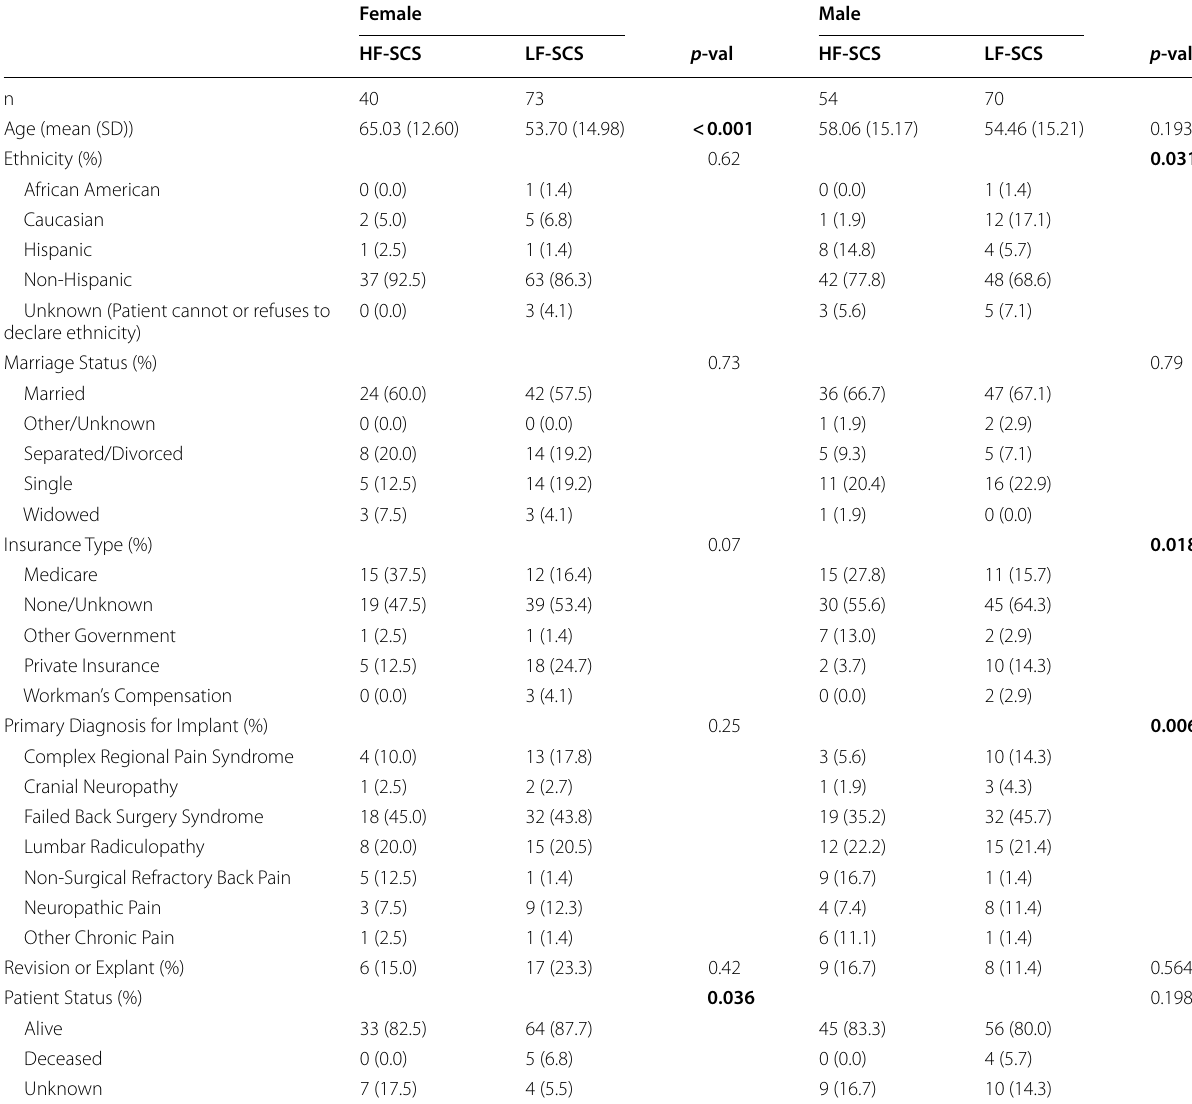
Table 4 Patient characteristics by type of stimulator and